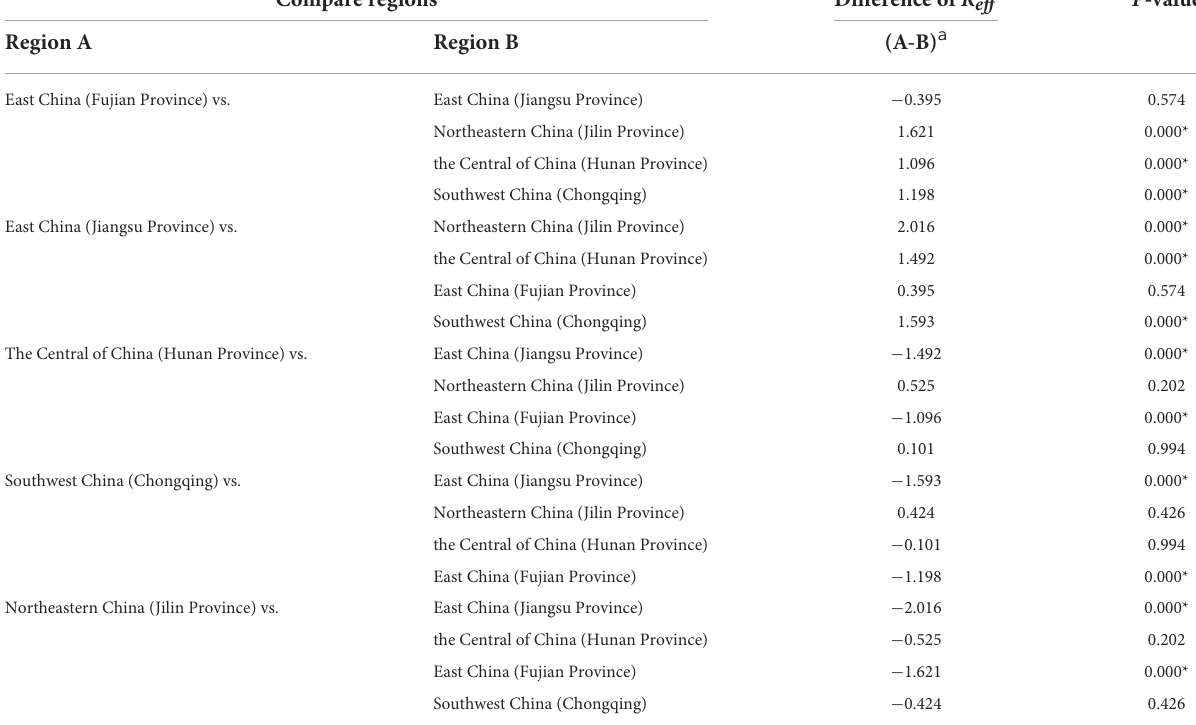
TABLE 2 Comparison of the transmissibility of HFMD in the study regions. Compare regions Difference of R eff P- value Region A Region B (A-B)